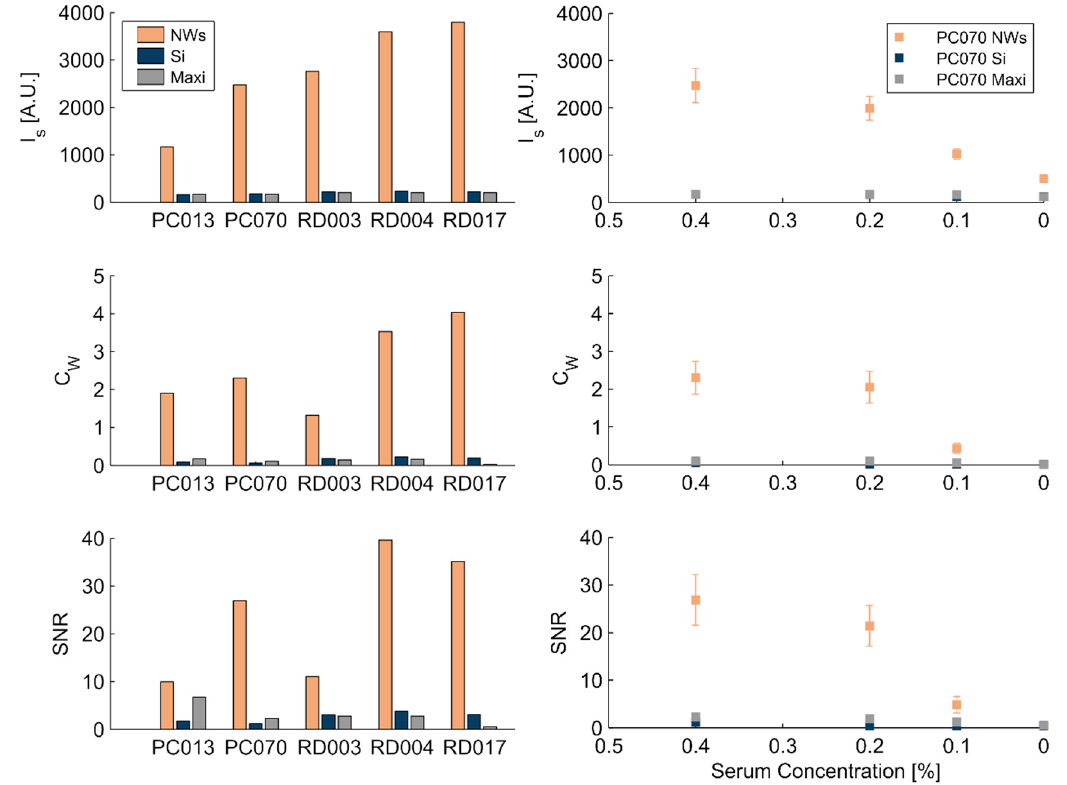
Figure 4. Left: extracted values of signal intensity I s , Weber contrast C W , and signal to noise ration ( SNR ) for the various scFvs on the three substrates tested with 0.4% serum concentration. All three parameters are consistently higher on the nanowire substrates. Right: example of the effect of serum concentration for the PC070 scFv. Decreasing the serum concentration results in a decrease in the signal, with 0.1% concentration approaching the limit for reliable signal on nanowires. Data for all tested scFvs are shown in the Figure S1. Comparison graph in logarithmic scale are shown in the Figure